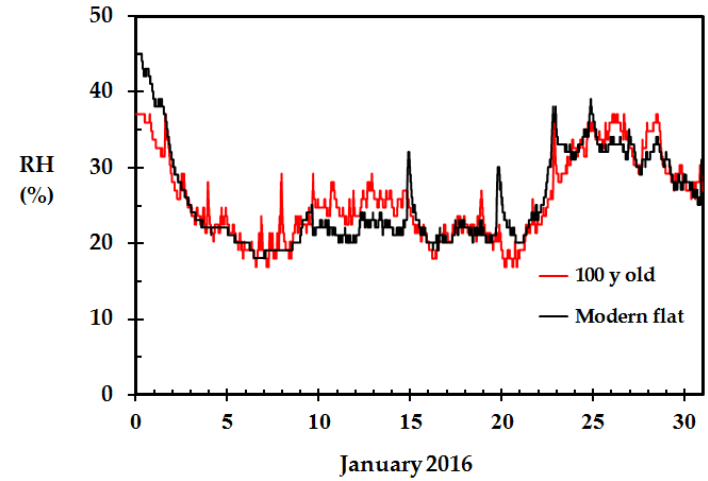
Figure 6. Recorded indoor RH for a 100 years old wooden home (inhabited by four persons) and a modern flat (inhabited by two persons) in Haugesund, Norway, during the cold snap in January